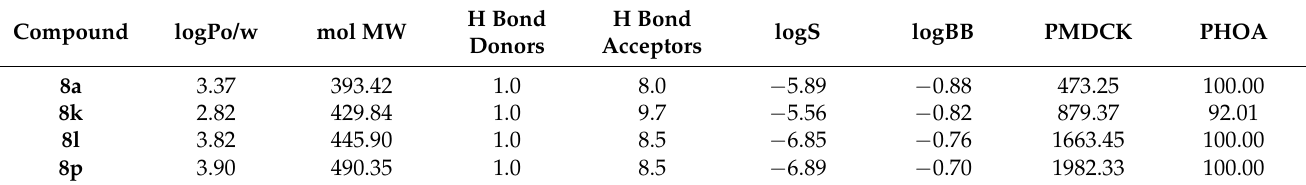
Table 3. Drug likeness score of most active